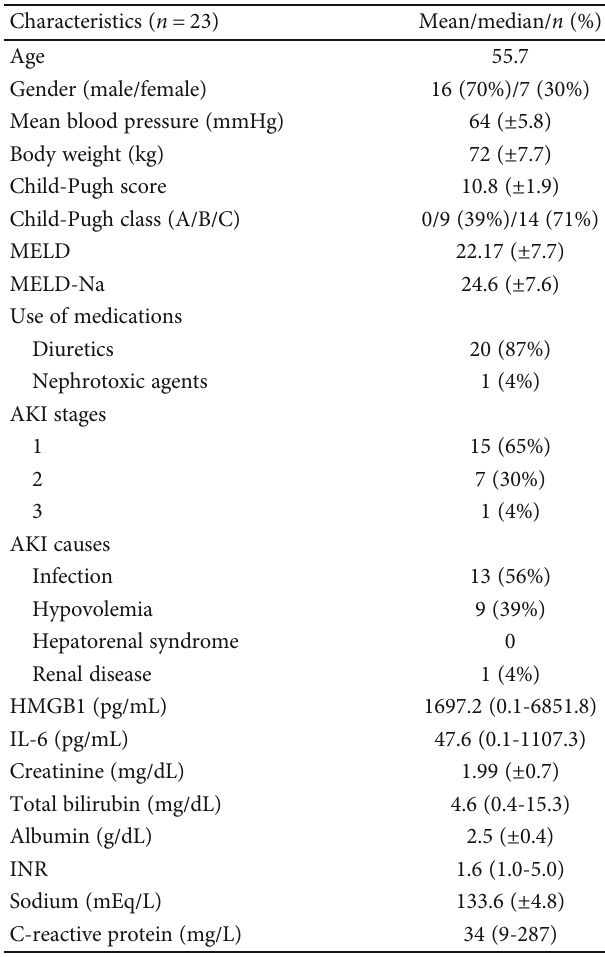
Table 1: Clinical and laboratory variables of 23 cirrhotic patients with